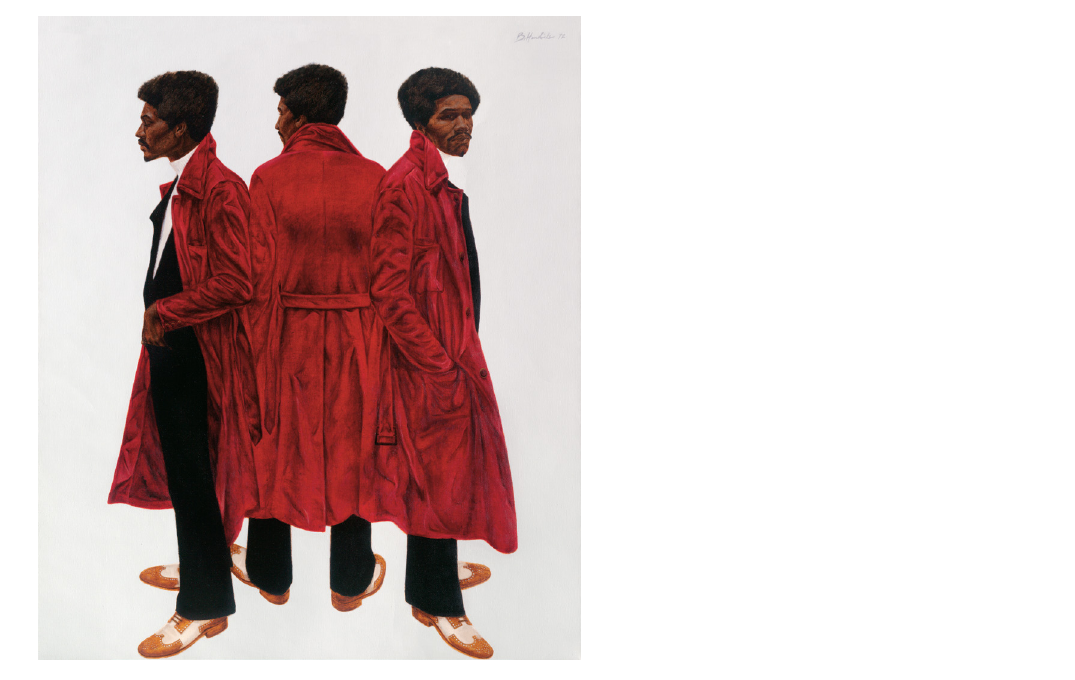
Figure 3. Hendricks, Barkley L., Sir Charles, Alias Willie Harris (1972). Oil, acrylic, and aluminium leaf on linen canvas, 84 1/8 x 72 in. ©Estate of Barkley L. Hendricks. Courtesy of Jack Shainman Gallery, New